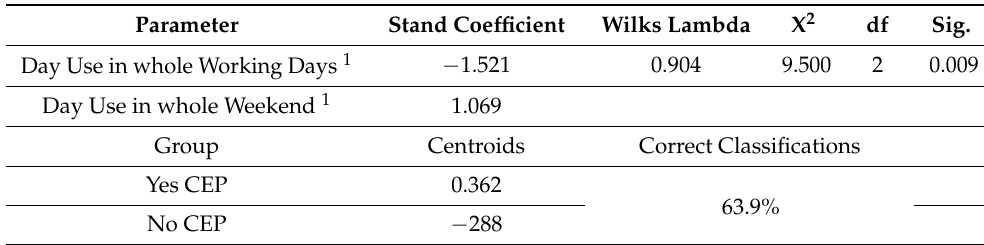
Table 13. Discriminant analysis on behavioral parameters by Coding Educational Program attendance. Parameter Stand Coefficient Wilks Lambda X 2 df Sig. Day Use in whole Working Days 1 − 1.521 0.904 9.500 2 0.009 Day Use in whole Weekend 1 1.069 Group